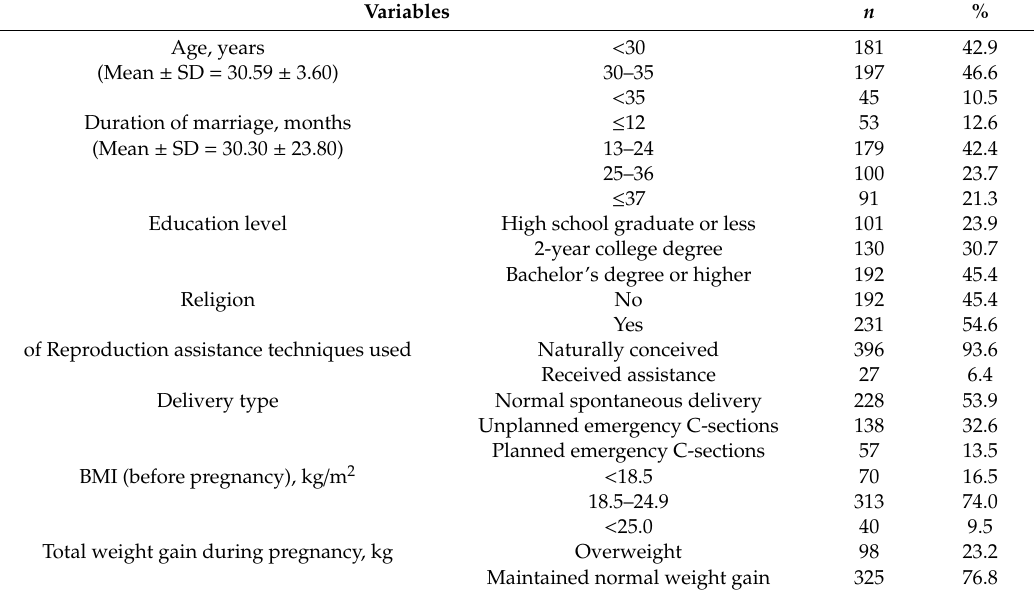
Table 1. General characteristics ( N =